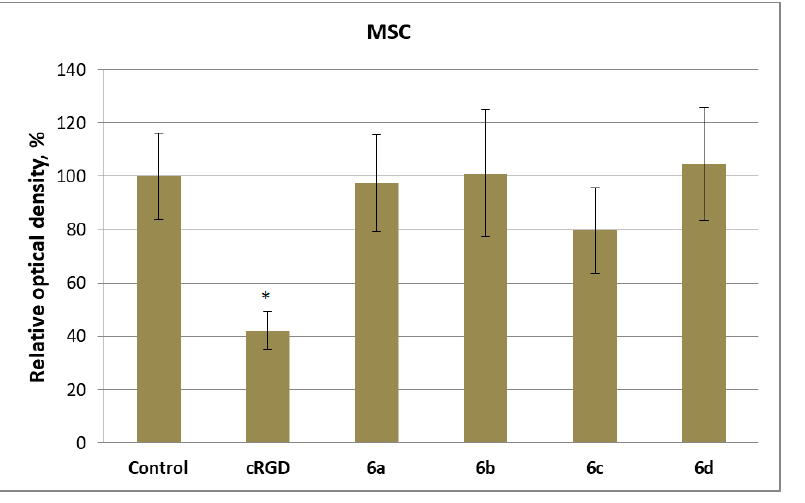
Figure 4. Cell viability established by the MTT test in the presence of compounds. Significant differences with the control ( p < 0.05) are shown with asterisks.